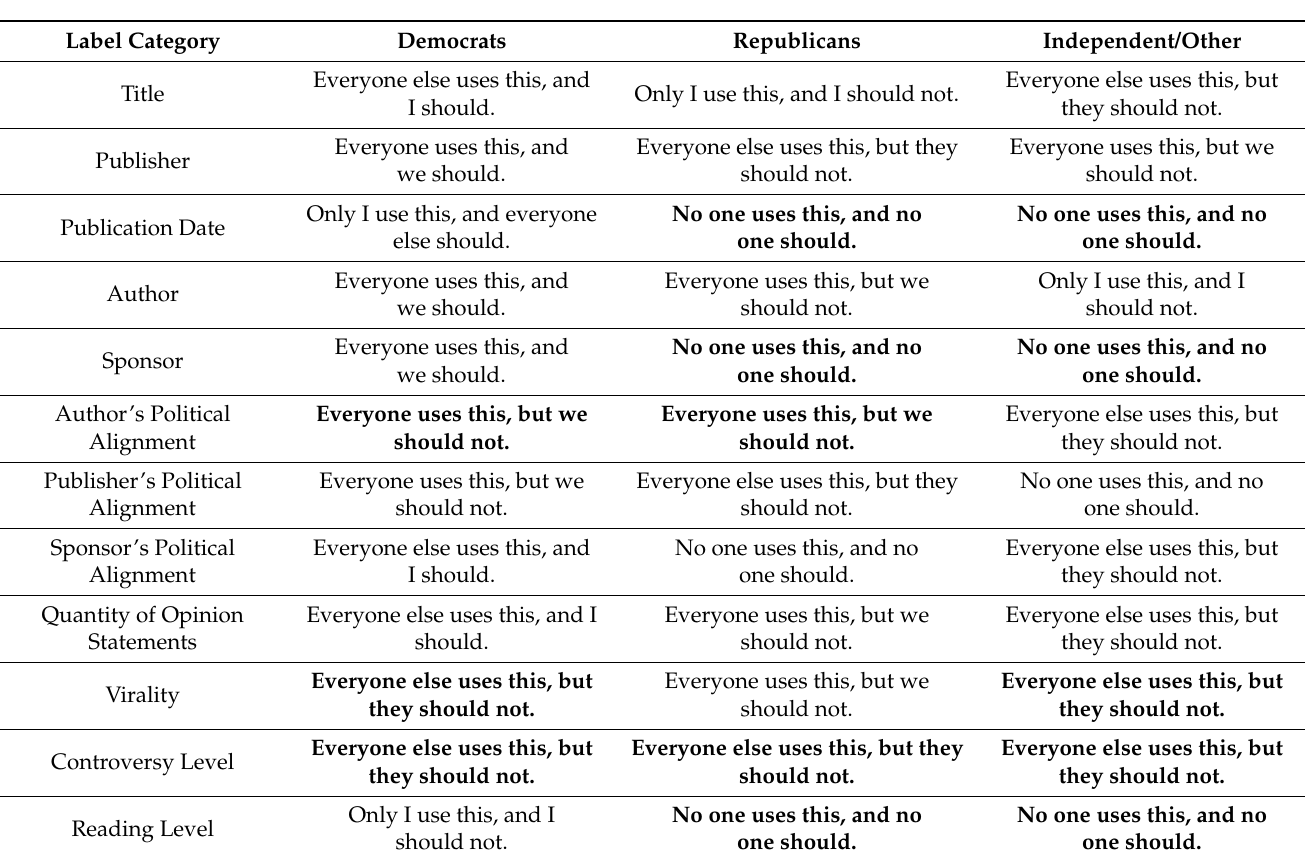
Table 8. Belief paradigms for each political party group, for each label category, based upon majority support for using the metric ‘a lot’ or ‘a great deal.’ Areas of agreement amongst political party groups are presented in bold in each